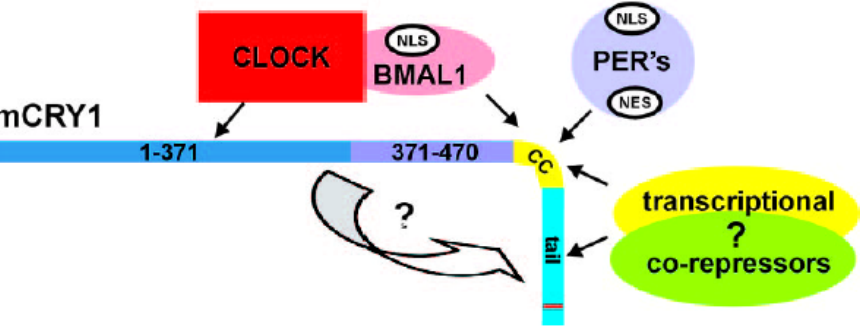
Figure 5. Representation of the co-operation of CRY molecule with the major cell cycle regulator-transcription factor heterodimer, CLOCK/BMAL1, transcriptional corepressors and PER proteins. (From [53], reproduced with permission from American Society for